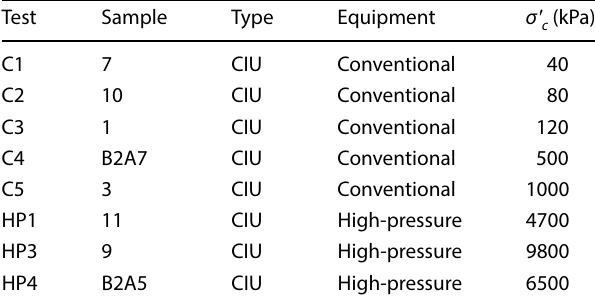
Table 2 Summary of CIU triaxial compression tests carried out on samples from the Experimental Site [6]